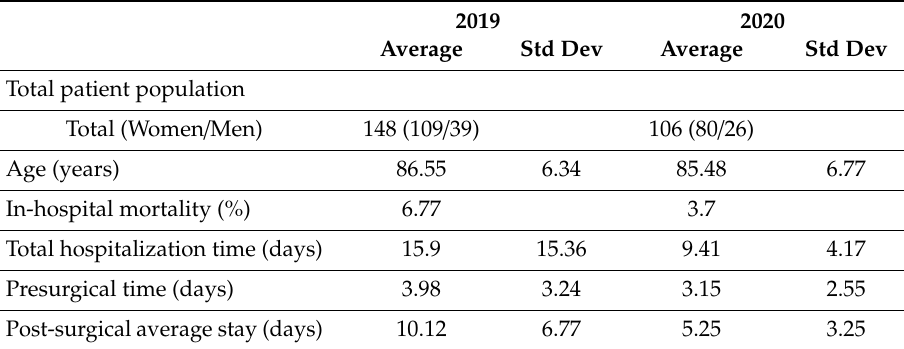
Table 1. Summary of descriptive statistical